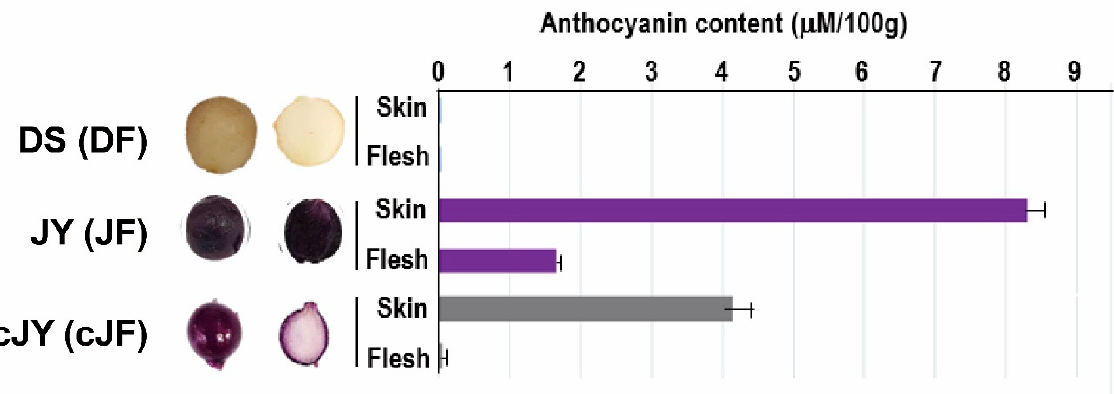
Figure 2. Tuber morphology and anthocyanin content assay indicates cJF had lower anthocyanin contents as DF. DS (DF in mRNAseq), JY (JF in mRNAseq), and cJY (cJF in mRNAseq). cJY, cultured